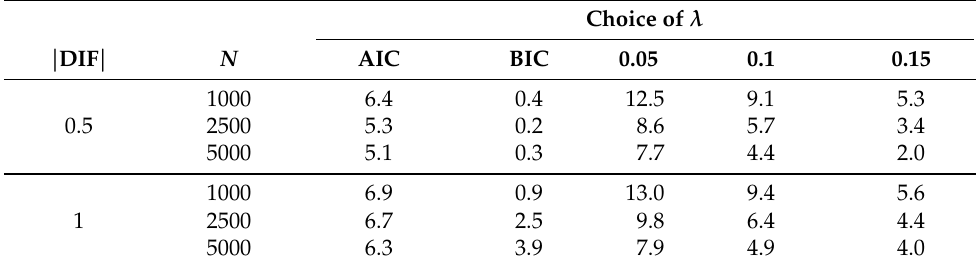
Table 1. Simulation Study 1: Average number of detected DIF effects e i .